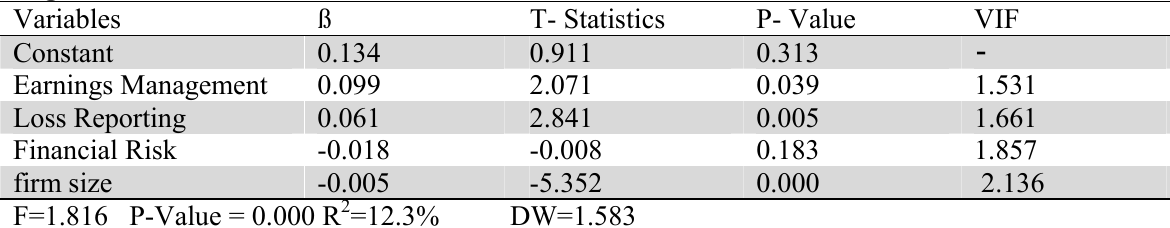
Regression Results